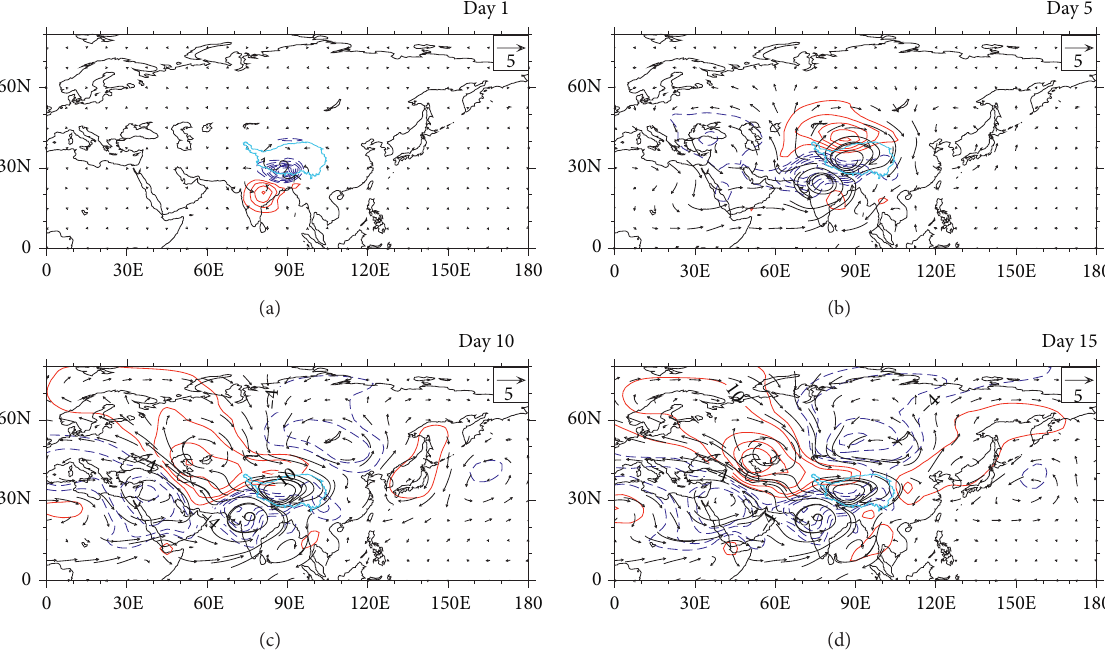
Figure 8: Steady 500hPa height (contours, units: gpm) and 500hPa wind (vectors, units: m · s − 1 ) anomalies generated by COM on (a) day 1, (b) day 5, (c) day 10, and (d) day 15.